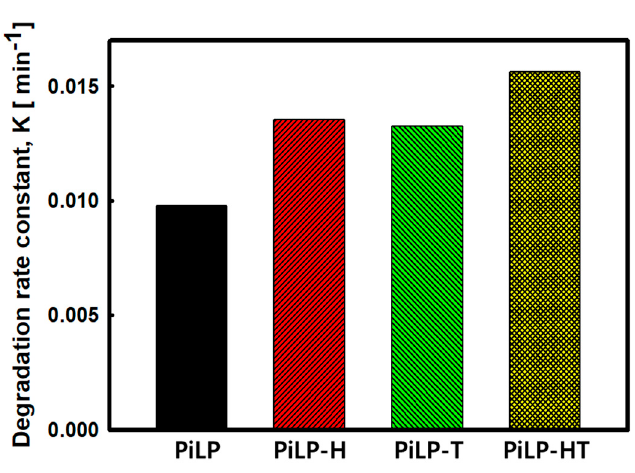
Figure 4. Comparison of the ASA decomposition rates obtained under various experimental conditions.